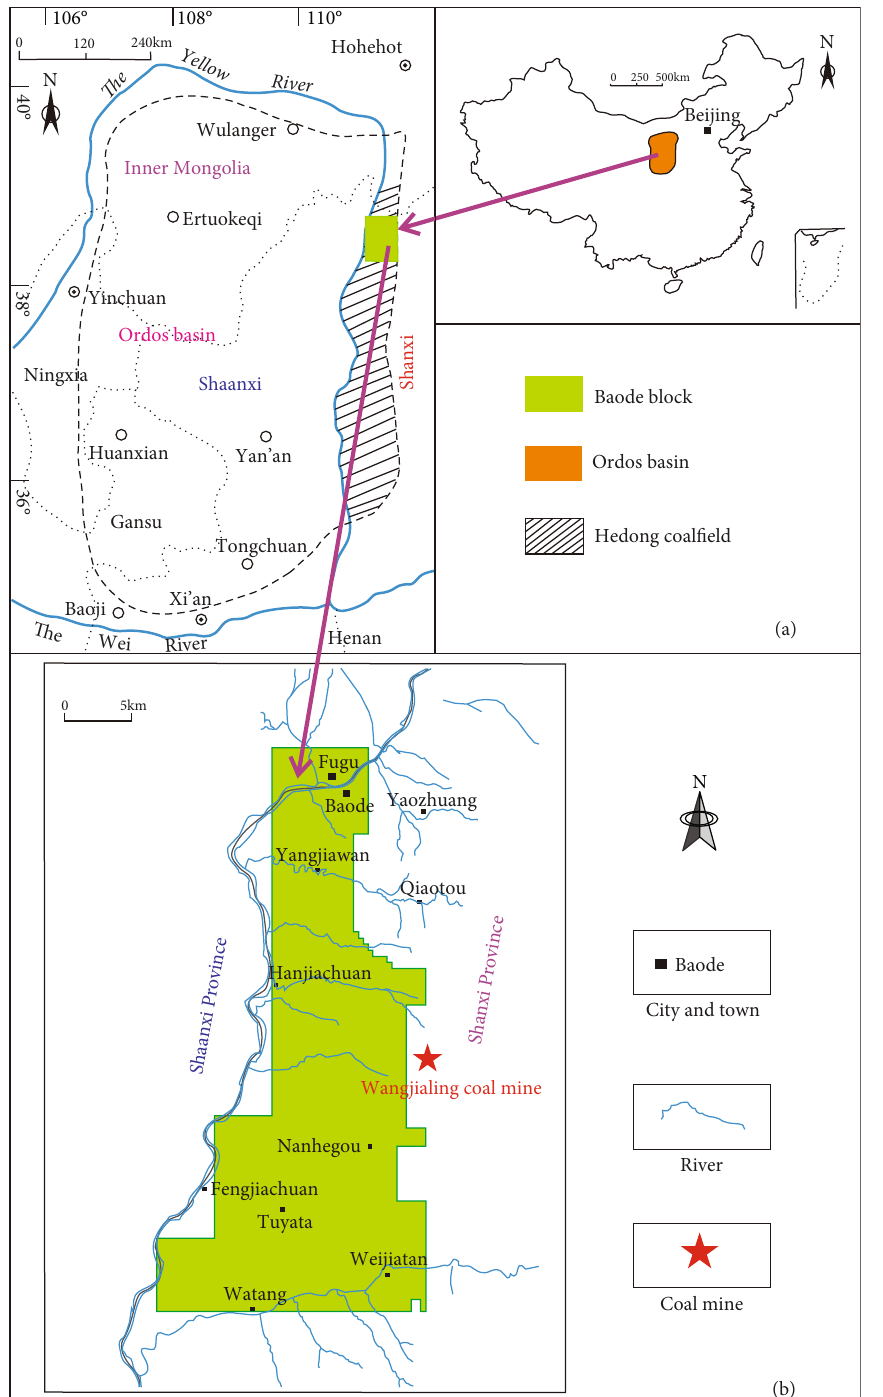
Figure 1: (a) Location of the Ordos Basin and Baode block. (b) Location of Wangjialing coal mine and the scope of the Baode